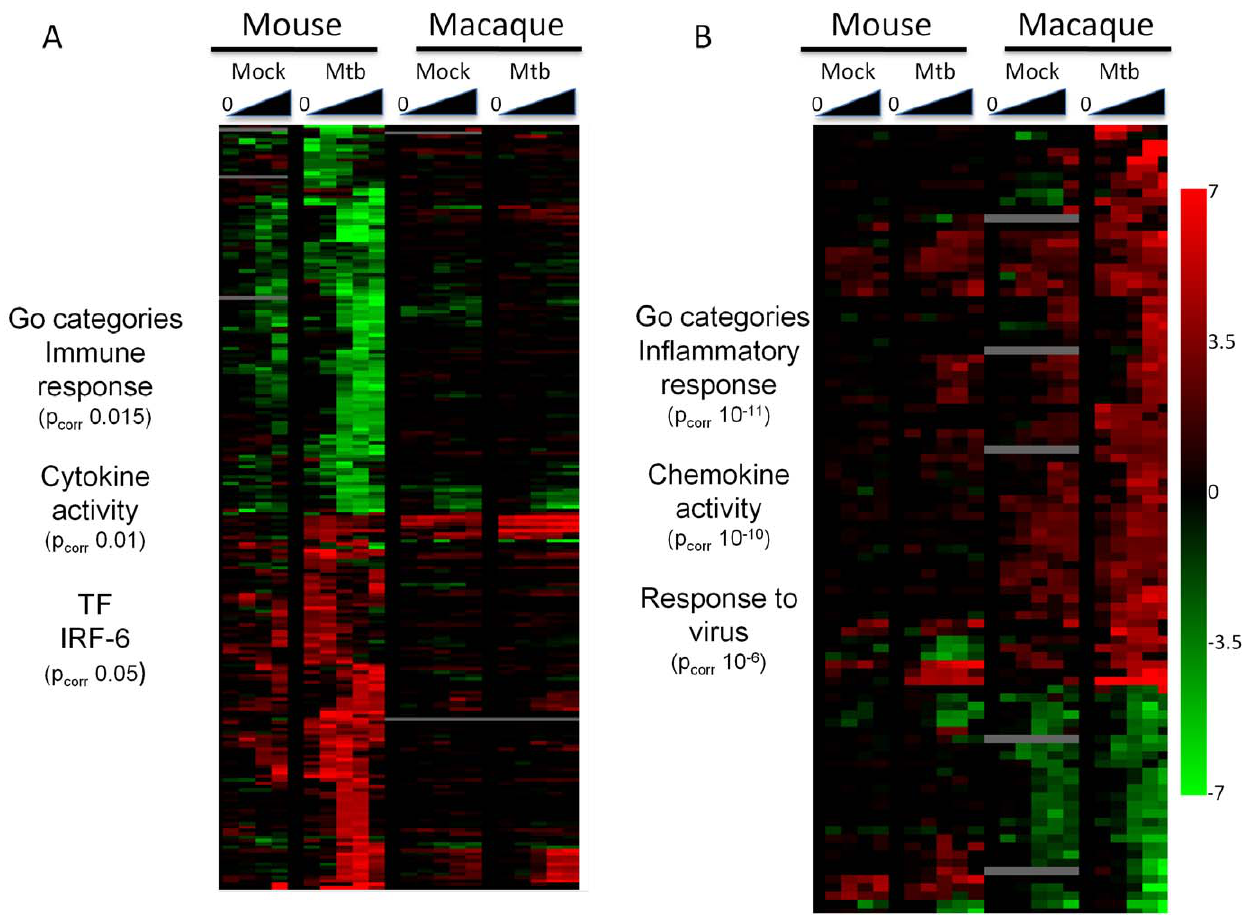
Figure 4. Response of AM to Mtb is species-specific. (A) Heatmap of genes identified as DE by infection of murine AM with Mtb. Also plotted are the expression values for the ortholog macaque genes following Mtb infection, and following mock infection. (B) Heatmap of genes identified as DE by infection of macaque AM with Mtb. Also plotted are the expression values for the ortholog murine genes following Mtb infection. Overrepresented GO categories are shown next to each heatmap. The scale represents fold change from time point 0 of 2 7– + 7 (log 2 ).